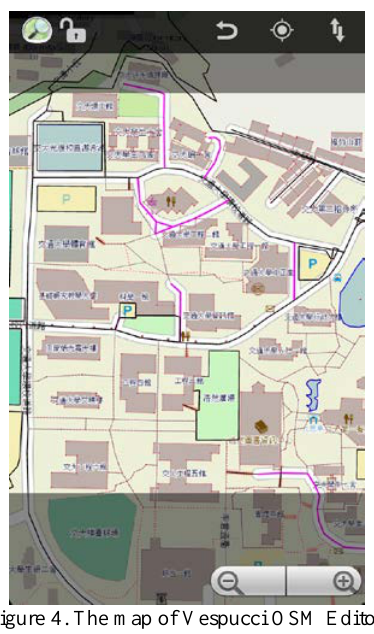
Figure 4. The map of Vespucci OSM Editor.